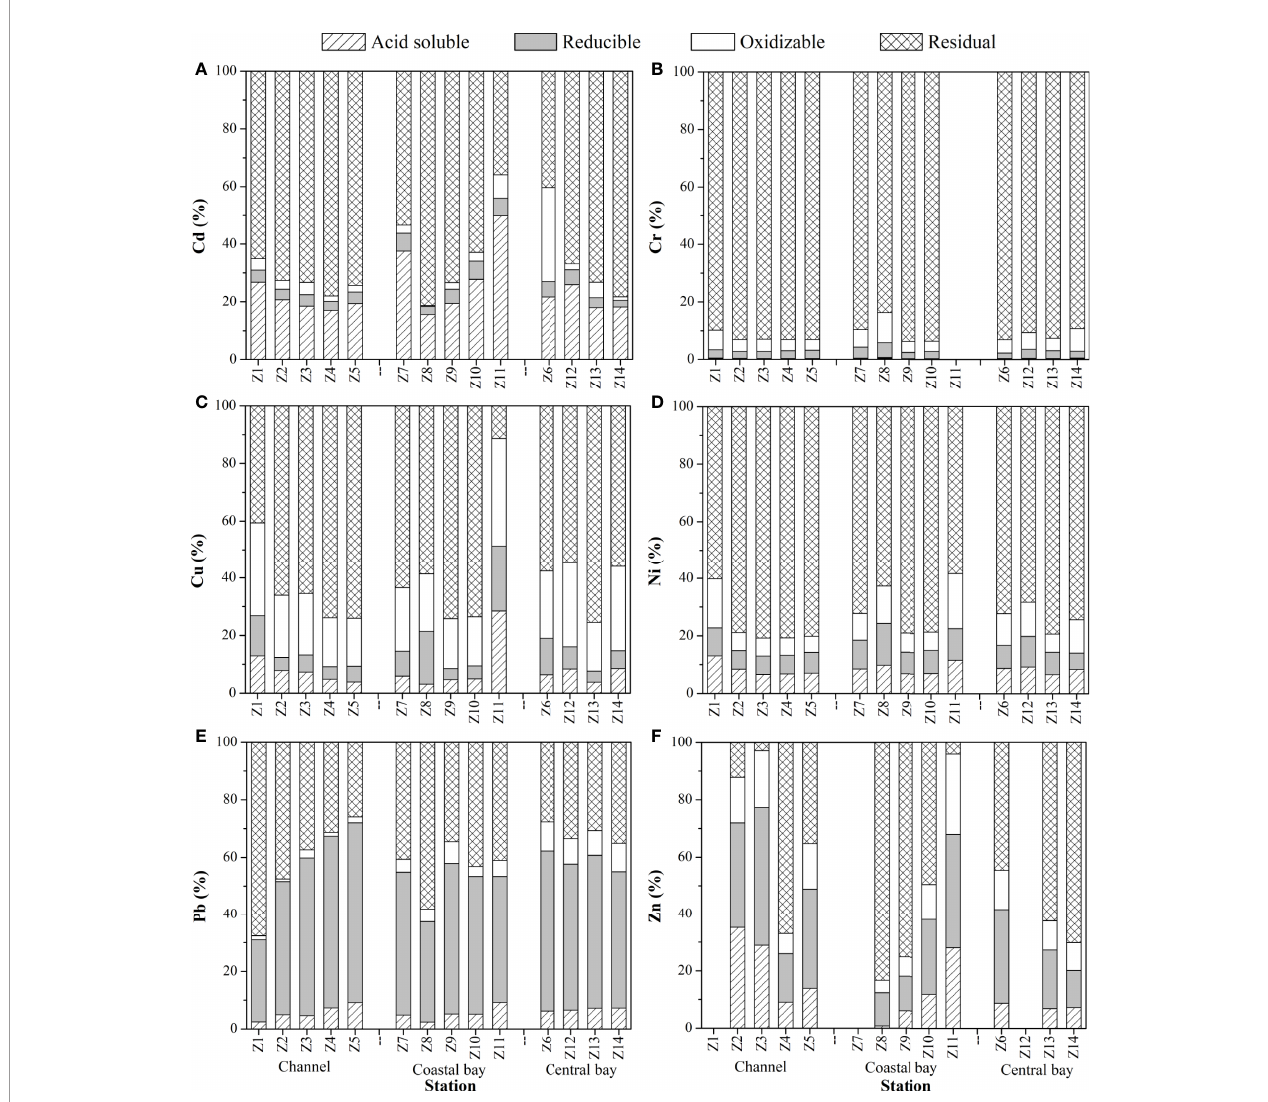
FIGURE 3 | Distributions of Cd (A) , Cr (B) , Cu (C) , Ni (D) , Pb (E) and Zn (F) in different geochemical fractions in the surface sediments of Zhanjiang bay in spring.